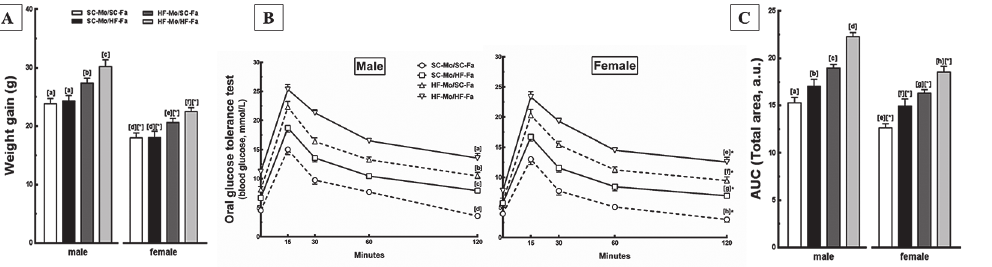
Fig 3. Offspring data. (A) Total weight gain, (B) Oral glucose tolerance test (OGTT) and (C) Area under the curve (AUC) of OGTT of the male and female offspring at 12-weeks old. Data are expressed as the mean and SD for N = 5 mice per group in all analyzes (one way ANOVA and the posthoc test of Holm- Sidak). Same letters represent equal groups with no statistical difference while different letters represent different groups from each other, with statistical difference ( P < 0.05), * different from the corresponding counterpart ( P < 0.05). Abbreviations: father that received standard chow (SC-Fa); father that received high-fat diet (HF-Fa); mother that received standard chow (SC-Mo); mother that received high-fat diet (HF-Mo). Offspring of SC mother and SC father (SC-Mo/SC-Fa); offspring of SC mother and HF father (SC-Mo/HF-Fa); offspring of HF mother and SC father (HF-Mo/SC-Fa); offspring of HF mother and HF father (HF-Mo/HF-Fa); area under the curve (AUC) and arbitrary units (a. u.).